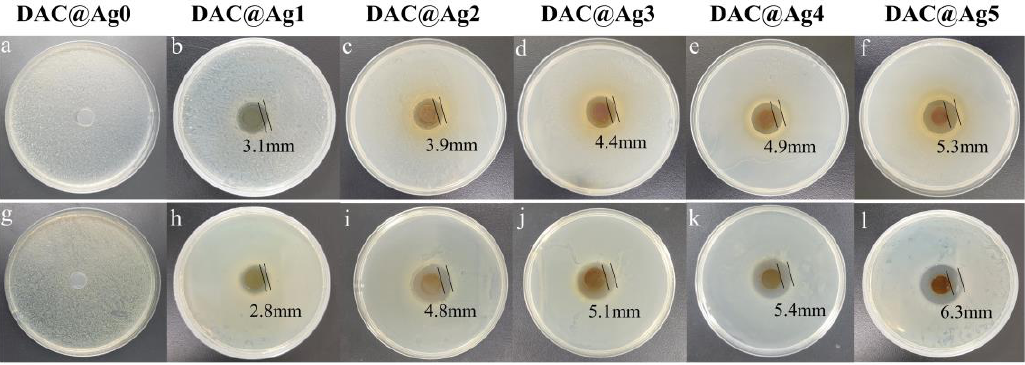
Figure 9. Antibacterial test of DAC@Ag0-DAC@Ag5 films. Inhibition images of the DAC@Ag0- DAC@Ag5 films against E. coli ( a – f ) and S. aureus ( g – l ).